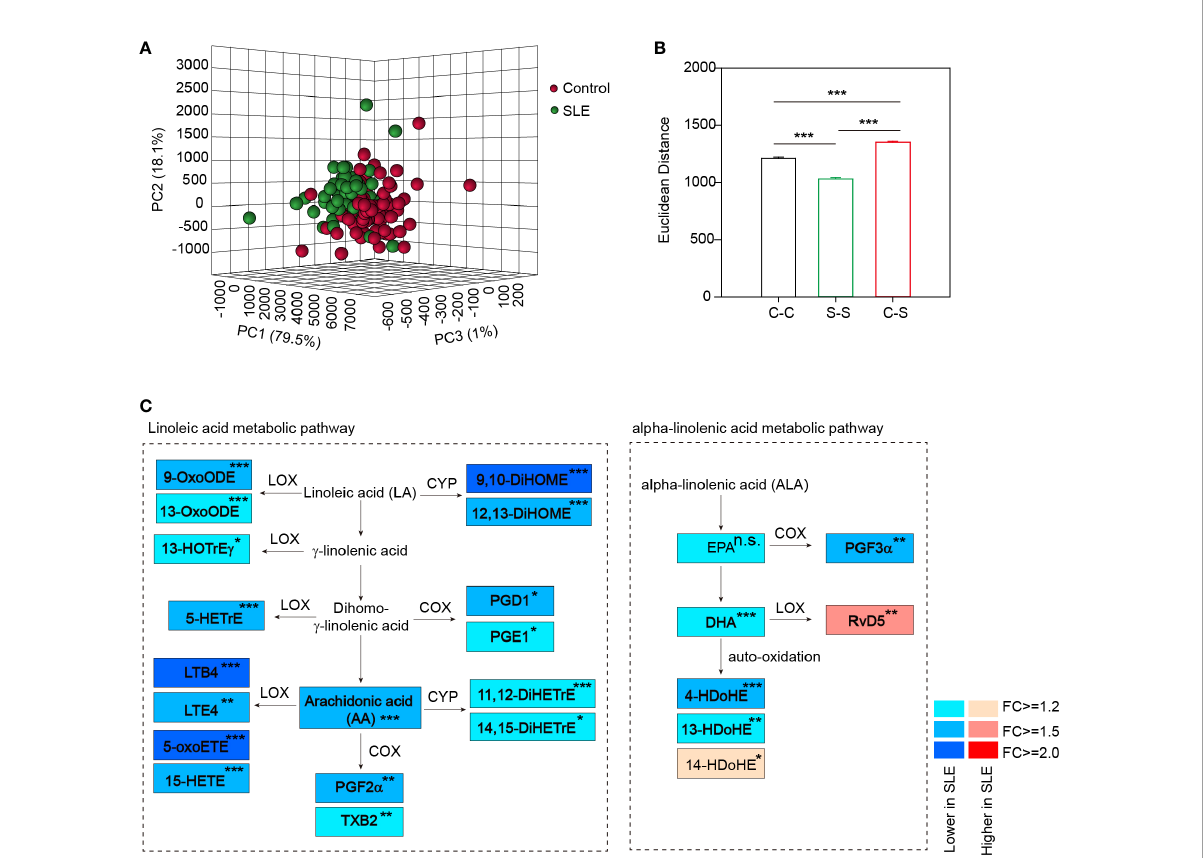
FIGURE 2 Distinct oxylipin expression pro fi le in SLE patients. (A) PCA plot based on all 92 quanti fi ed oxylipins showed a separation of SLE patients and healthy controls. (B) Euclidean distance between SLE patients and healthy controls in the current cohort based on the global alterations of oxylipin abundance. C-C, distance within control group; S-S, distance within SLE group and C-S, distance between SLE and healthy controls. ***, p<0.001 by rank-sum test. (C) Diagram summarizing the concentration changes of oxylipins in linoleic acid metabolism and alpha-linolenic acid metabolism pathway. Signi fi cantly changed metabolites were indicated in rectangle with different colors. The fold changes of the altered metabolites in SLE patients were showed. *, p<0.05; **, p<0.01; ***, p<0.001. and n.s., non-signi fi cant. Linoleic acid (LA), g -linolenic acid, Dihomo- g -linolenic acid and a -linolenic acid (ALA) were not included in the 128 molecules analyzed. LOX, COX and CYP represent the enzymes that catalyze the formation of